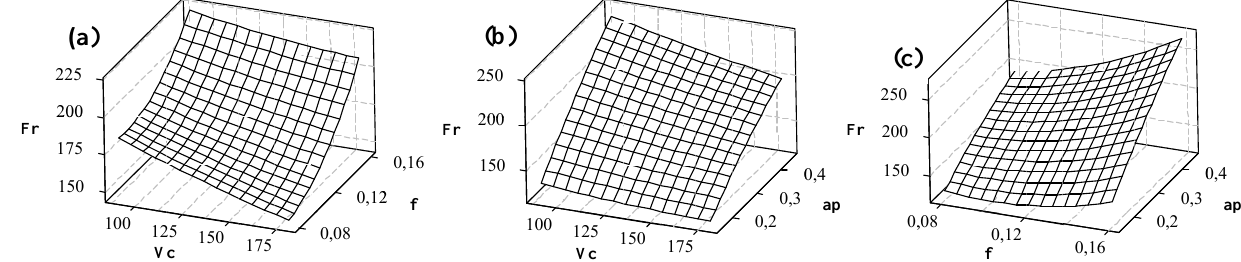
(a) 3D surface plots for interaction effects of feed rate and cutting speed, (b) depth of cut and cutting speed, and (c) depth of cut and feed rate on thrust